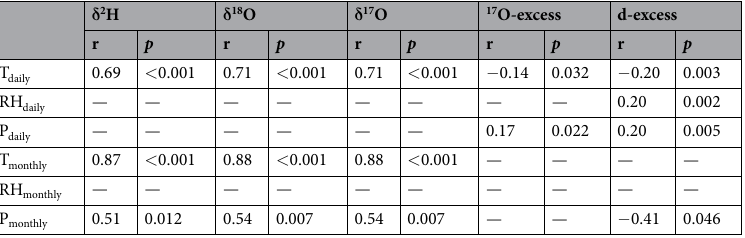
Table 2. The relationships between the precipitation isotopes ( δ 2 H/ δ 18 O/ δ 17 O), 17 O-excess, d-excess and local meteorological parameters (temperature (T), relative humidity (RH) and precipitation amount (P)) at both daily and monthly time scales over the study period. “ − ” indicates insignificant correlation.